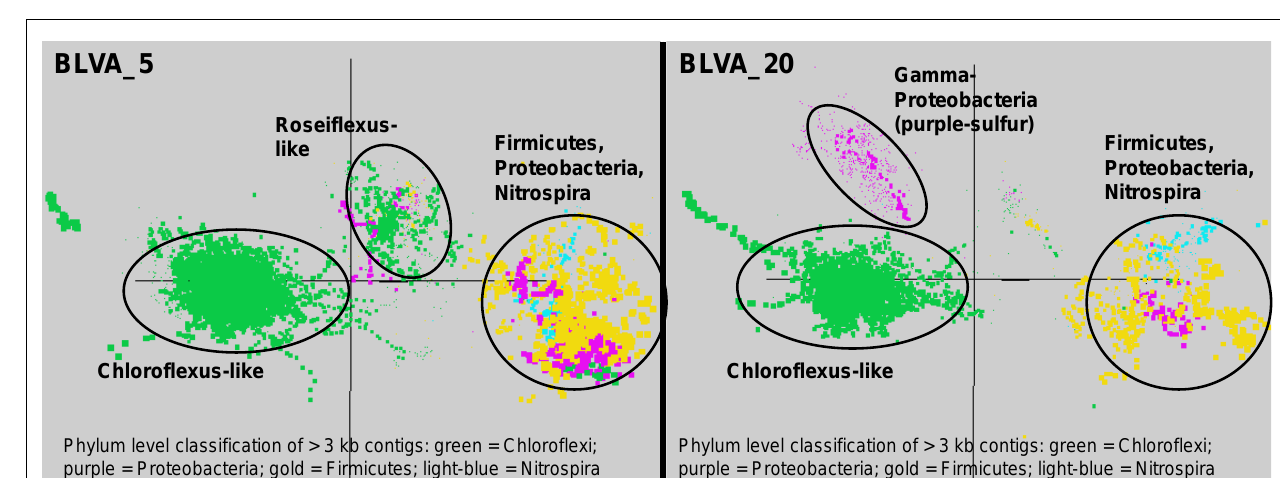
populations of Chloroflexus spp., Firmicutes, Nitrospira, and additional proteobacteria, but only BLVA_20 contained numerous scaffolds corresponding to the population of purple-sulfur bacteria (Gamma-proteobacteria, family Chromatiaceae , average G + C ∼ 64%) that is notably absent in